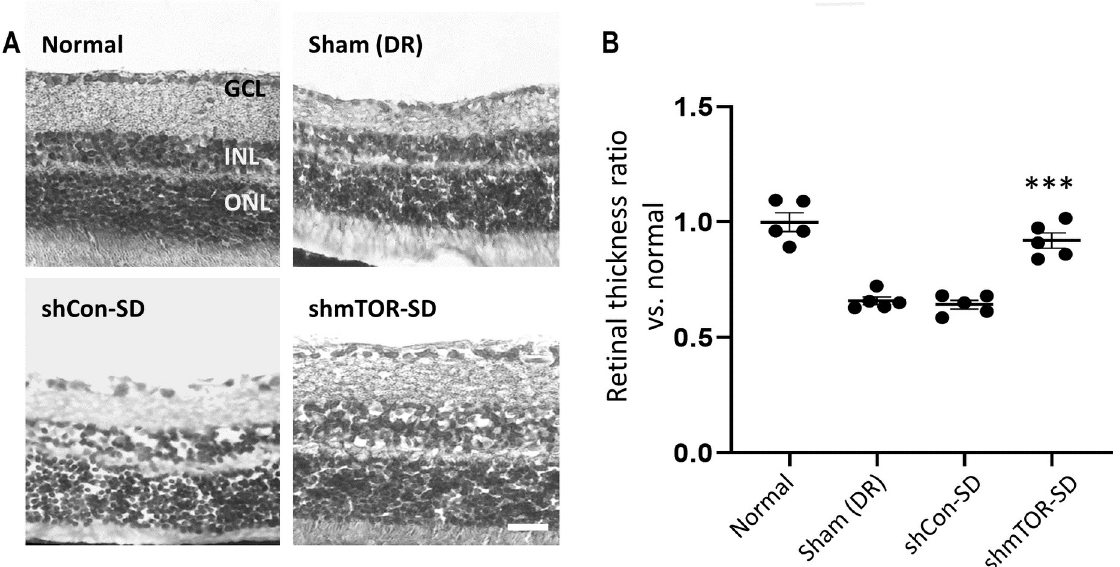
Fig 4. Visualization of retinal cell layers. (a) H&E staining was used to demonstrate that rAAV2-shmTOR-SD significantly reduced retinal cell layer thinning, which occurred in mice administered with a control shRNA-containing virus vector as well as sham-treated mice, suggesting that the therapeutic virus vector may possess neuroprotective properties. Scale bar = 50 μ m. (b) Retinal cell layer thickness ratios normalized relative to normal control mice. Data represented as mean ± SEM (n = 5).